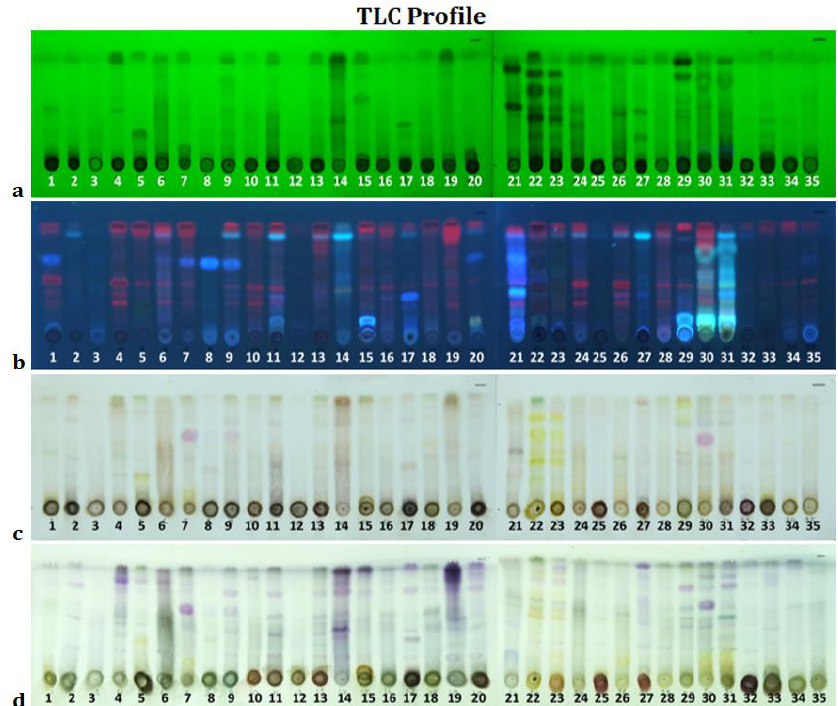
Figure 2. The TLC profile of Halmahera plant extracts. The TLC spots were visualized (a) under UV 254nm, (b) UV 366nm, (c) with cerium, and (d) vanillin. The list of Halmahera plant extracts (number 1-35)